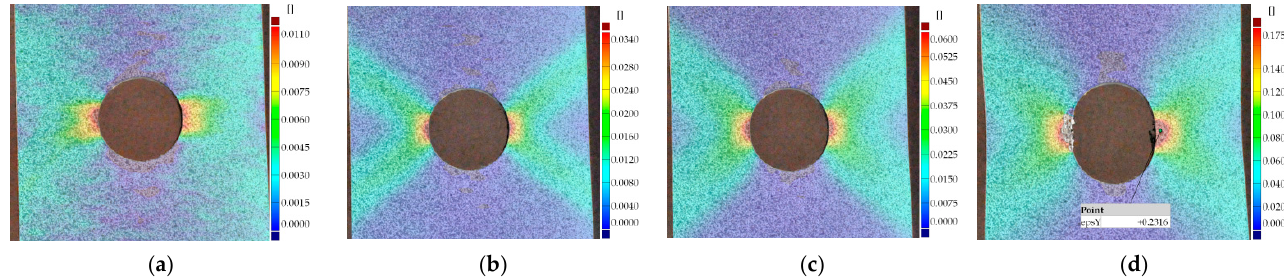
Figure 10. Distribution of strains on the surface for sample no. 2 with circular holes for strain: ( a ) ε TOT = 0.45%; ( b ) ε TOT = 0.50%; ( c ) ε TOT = 0.75%; ( d ) ε TOT = 1.58.